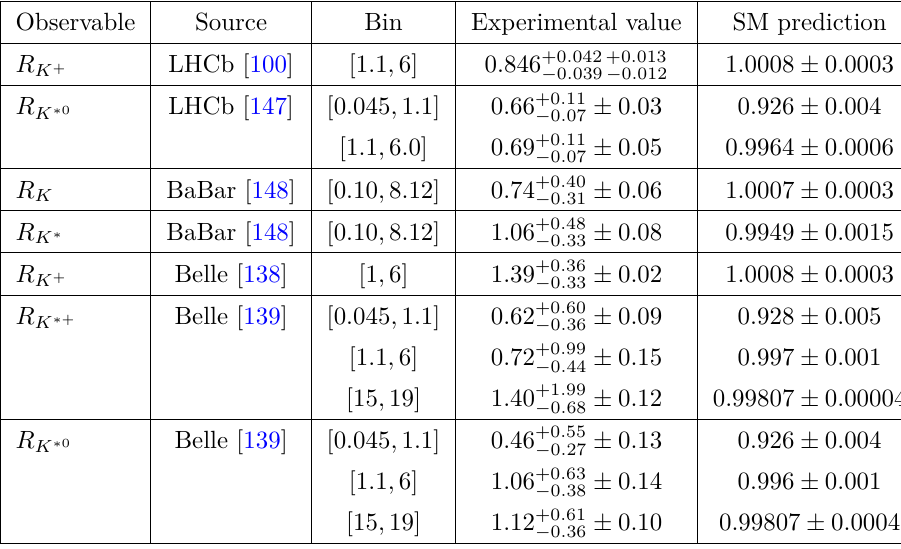
Table 8. Table of R observables used in the analysis. The stated SM predictions are our K ( ∗ ) calculations through flavio